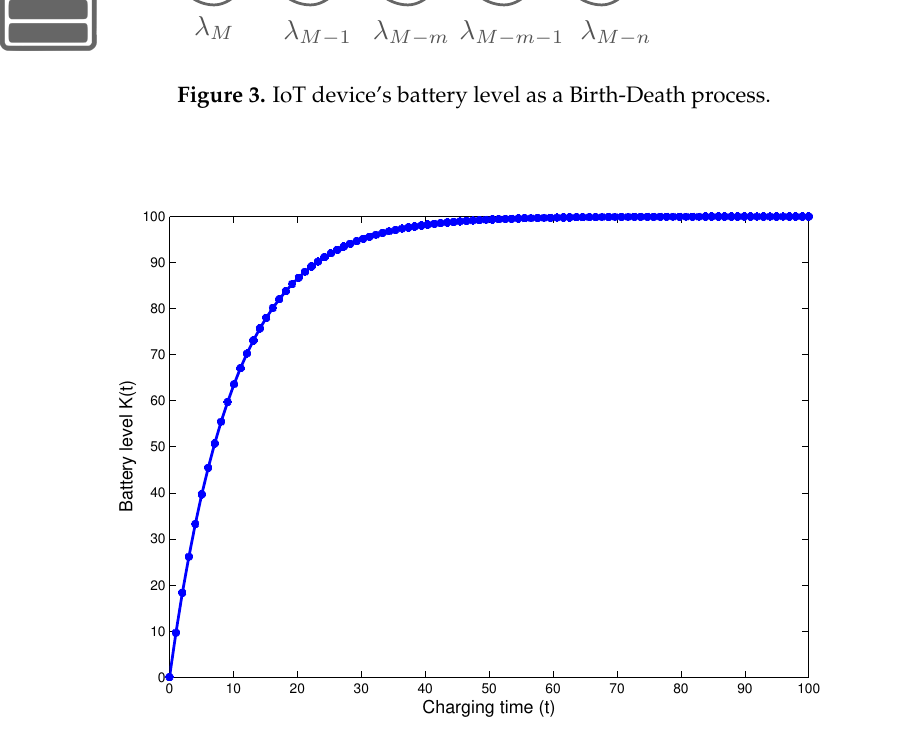
Figure 4. Battery recharging evolution over